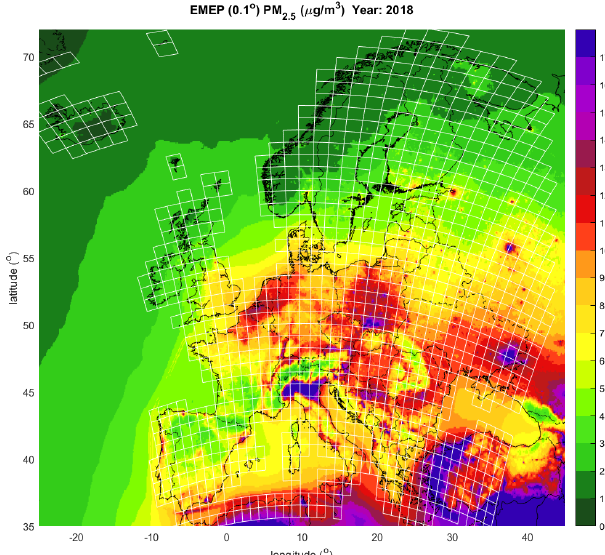
Figure 2. Annual mean PM 2 . 5 concentrations calculated with the EMEP model at 0.1 ◦ for 2018. Shown are the uEMEP tiling regions used in the calculations. In total, 1097 100km × 100km tiles with 100m resolution are used to model Europe.